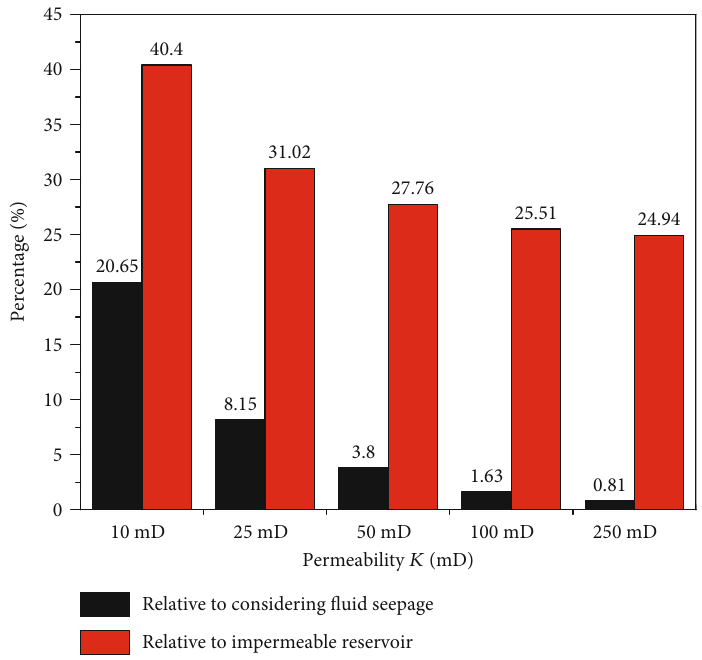
Figure 13: Reduction percentage of formation breakdown pressure from the case of considering seepage force to those from other